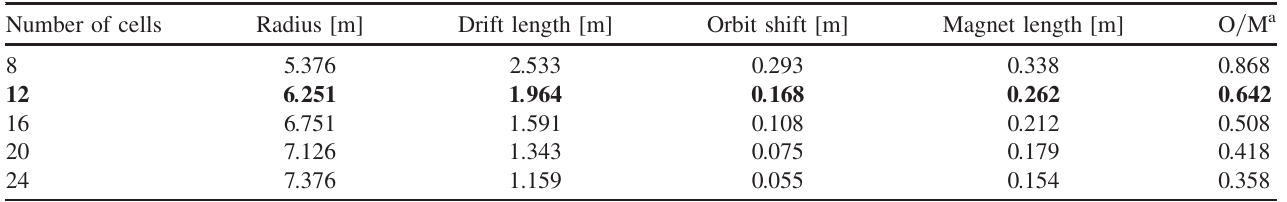
TABLE II. Geometrical lattice parameters as a function of number of cells for a 0 : 729 GeV =c machine, that is a kinetic energy of 0.250 GeV for a proton.